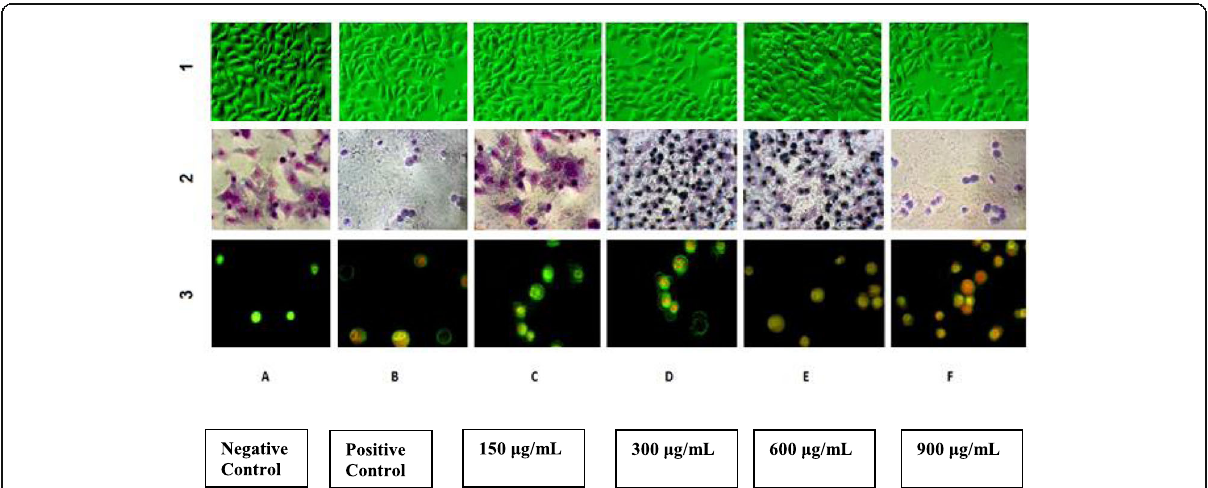
Fig. 6 Row 1: Representative light micrographs of HEp-2 cells (Magnification 100X). Row 2: after staining with Giemsa of HEp-2cells (Magnification 200X). Row 3: Represents Comet formation by Single cell gel electrophoresis of HEp-2 cells (Magnification 400X). a Negative control with untreated cells; b Positive control with Camptothecin (5mM; 25 μ L); c , d , e and f are HEp-2 cells treated with the water extract of Semecarpus parvifolia leaves at 150, 300, 600 and 900 μ g/mL concentrations for 24 hours